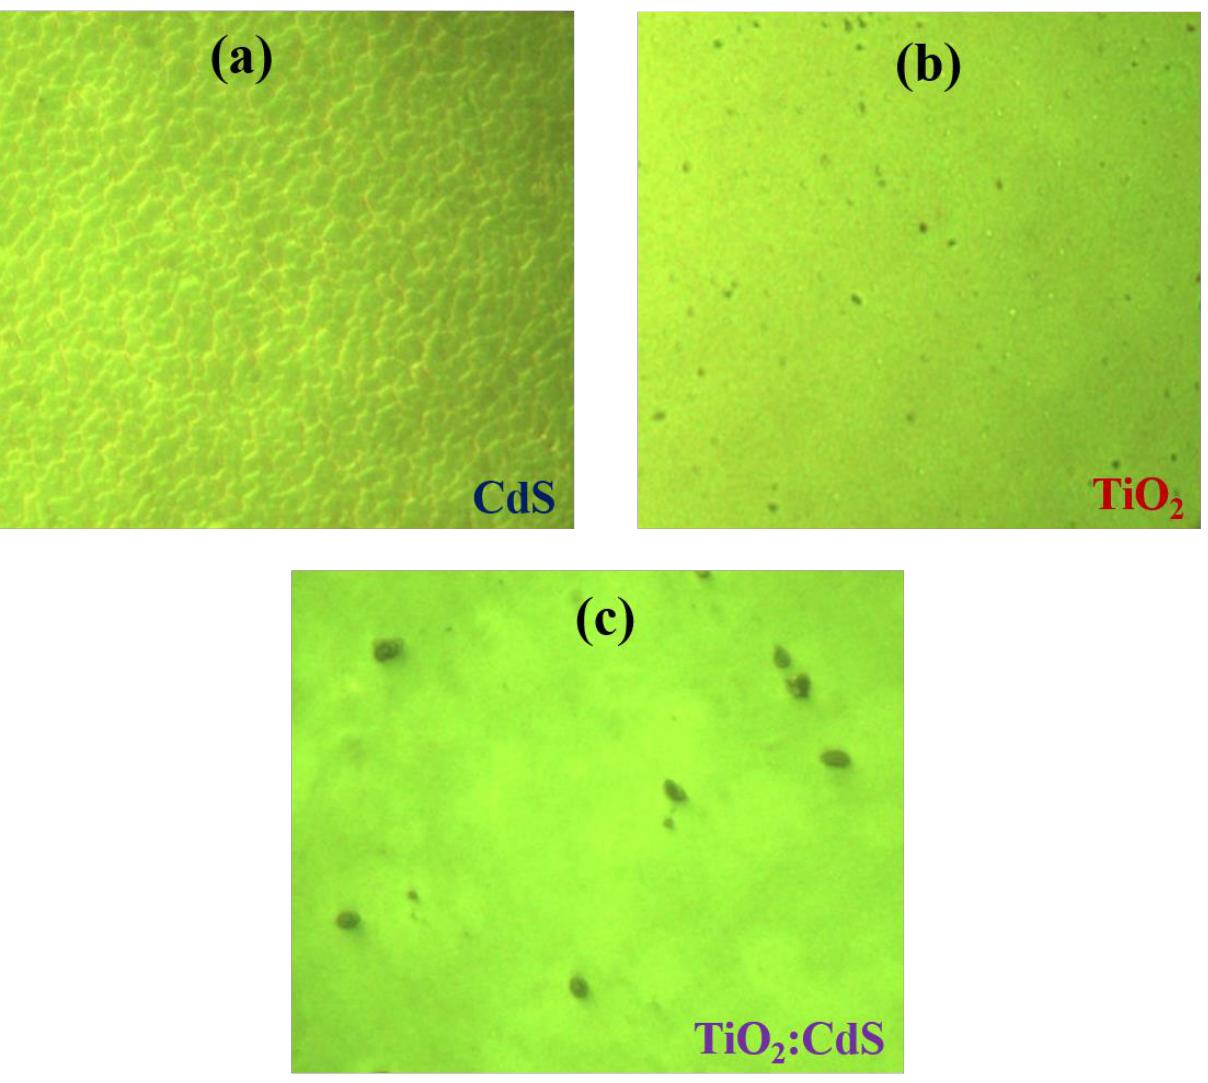
Figure 7. Optical microscopy of ( a ) CdS, ( b ) TiO 2, and ( c ) TiO 2 :CdS thin films at 1000×.